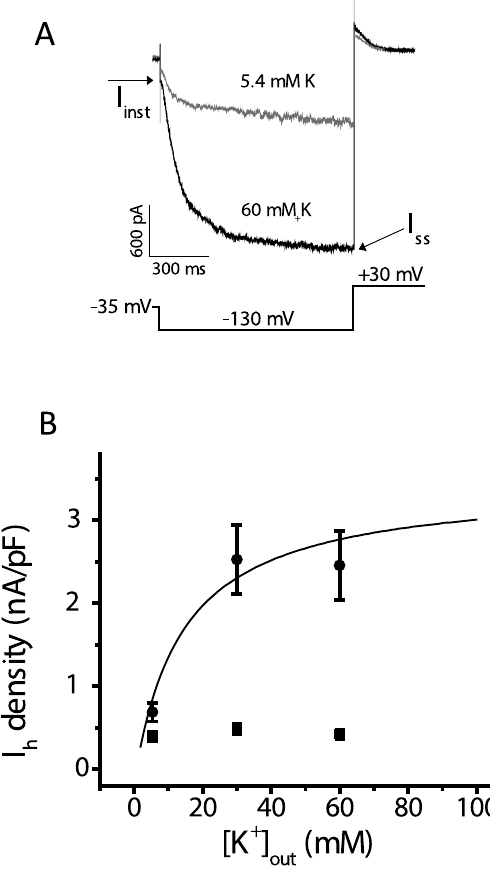
Figure 2. Raising extracellular potassium increases I h amplitude at − 130 mV in CHO cells that express the HCN1 isoform. ( A ) Representative traces of I h elicited by the voltage protocol shown below them from the same cell exposed to extracellular potassium concentrations of 5.4 and 60 mM. The magnitude of I h (for both inward current determined at − 130 mV and outward current determined at + 30 mV) was calculated as the difference between the instantaneous current at the beginning of each pulse (I inst ) and the steady-state current (I ss ) at the end of the pulse ( arrows ). Note the large difference in inward current measured at − 130 mV and very little difference in current measured at + 30 mV between the two extracellular solutions. ( B ) Amplitudes of I h density (nA/pF) measured at − 130 mV (inward current) and + 30 mV (outward current), plotted as a function of the extracellular potassium concentration. Increasing extracellular K + from 5.4 mM to 30 mM and to 60 mM produced a concentration-dependent increase in the average amplitude inward I h , which was measured at the end of the voltage pulse to − 130 mV (filled circles; n = 22–32; ANOVA, P < 0.0001). The curved line represents a fit of the current density from individual cells to a Michaelis-Menten equation, yielding an apparent dissociation constant of 13.8 ± 7.1 mM. Maximum outward “tail” I h , which was measured 1 ms after the voltage step to + 30 mV to minimize the contribution of capacitance current, was not significantly affected by raising the concentration of extracellular potassium (filled squares; P = 0.12). The reversal potentials for I h in different concentrations of extracellular potassium and sodium were − 26 ± 5 mV (5.4 mM Na, 135 mM K), − 20 ± 4 mV (30 mM K, 110 mM Na), and − 5 ± 9 mV (60 mM K, 80 mM Na); extracellular sodium concentrations were reduced proportionally to maintain osmolarity (see Materials and